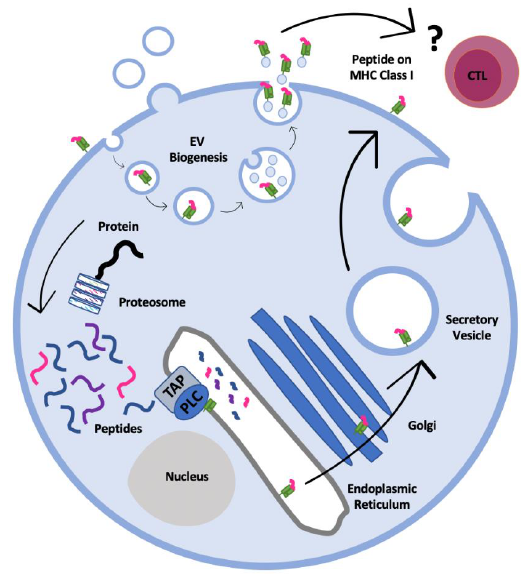
Figure 2. An outline of the human leukocyte antigen (HLA)/major histocompatibility complex (MHC) class I presentation pathway. The majority of the degradation of proteins destined for antigen presentation by HLA-I occurs in the cytosol by the proteasome. These peptides are then translocated into the lumen of the endoplasmic reticulum (ER), by the transporter complex associated with antigen processing (TAP), where further trimming may occur. Peptides are then loaded onto HLA-I molecules with the help of chaperones and the resulting stable complexes are transported from the endoplasmic reticulum to the surface of the cell. The incorporation of HLA-I molecules into exosomes generated through the MVB pathway is thought to occur by internalisation of HLA-I molecules from the cell surface.